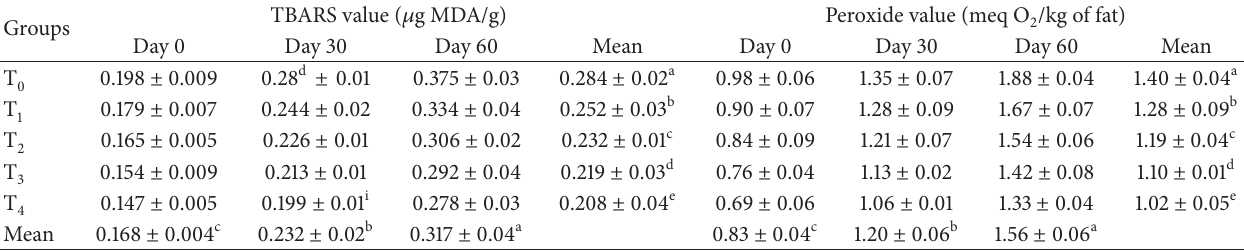
/kg of fat) in thigh meat. 2